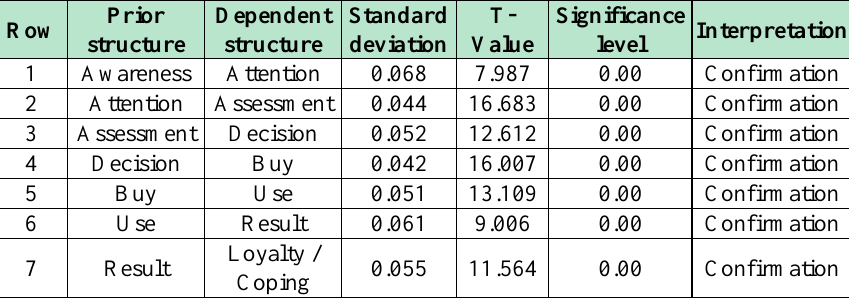
Table 5 - Summary of structural model evaluation